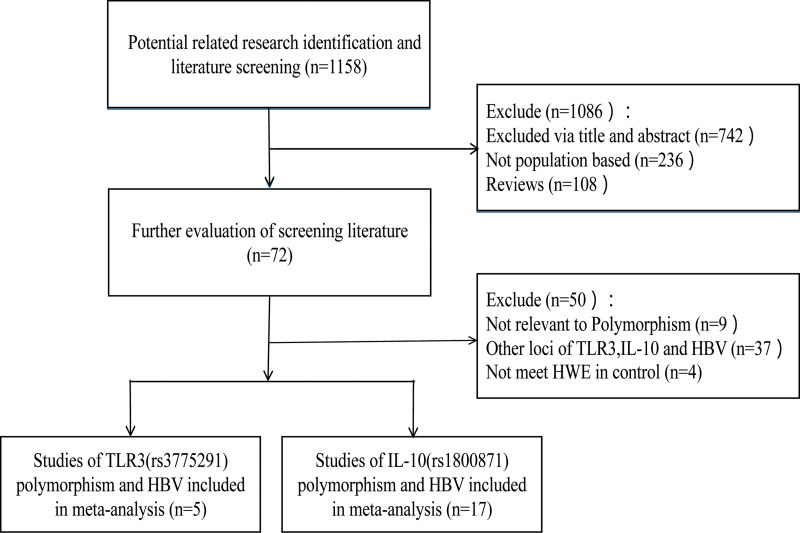
Screening flow diagram for inclusion in the study.